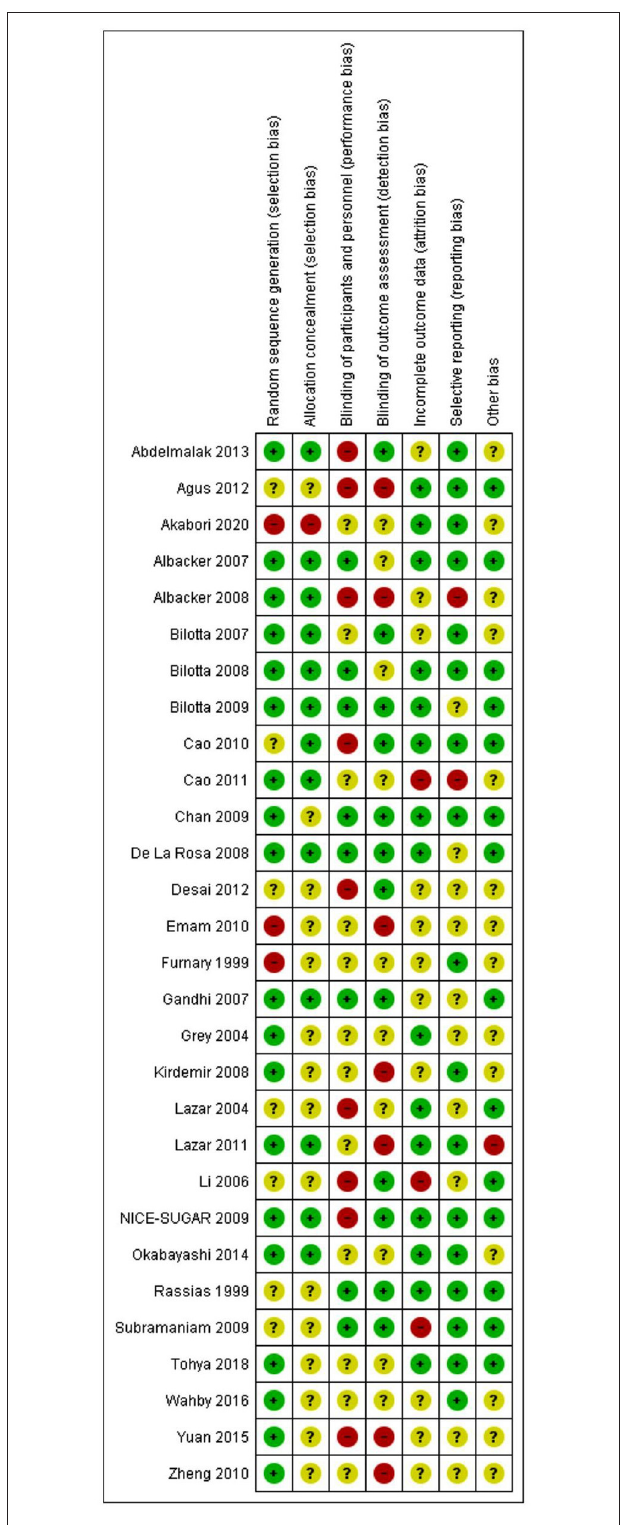
FIGURE 2 | Risk of bias summary for trials included in the meta-analysis ( n =